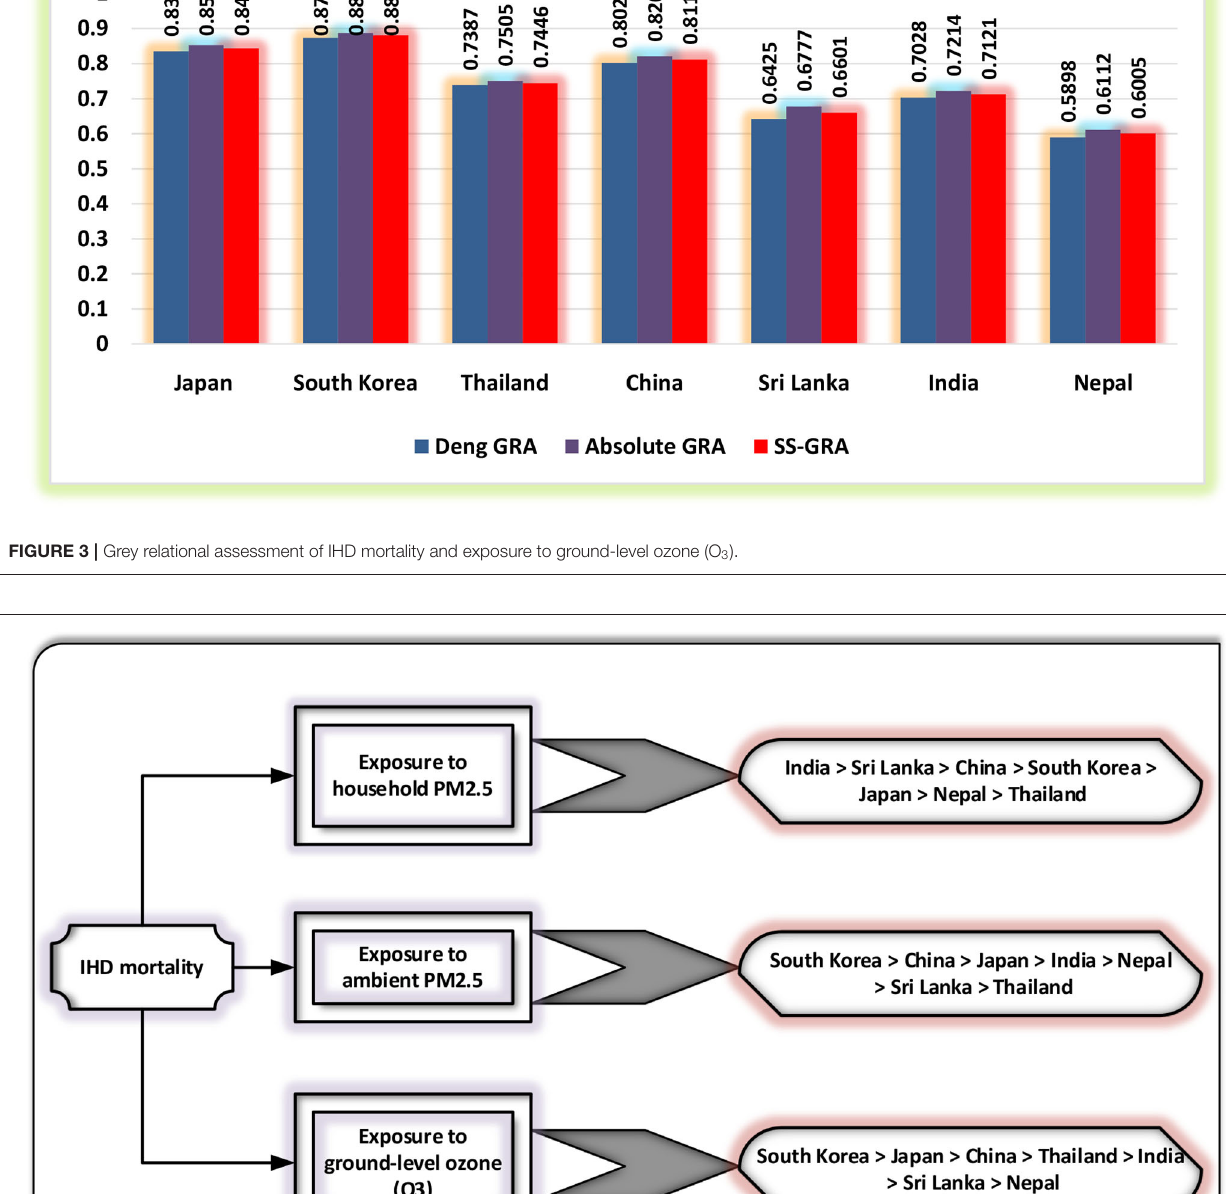
for the decision parameters. Figures 1 – 3 show a graphical representation of the GRA assessment between the studied variables and the air pollutants exposure. In addition, the ranking sequence based on GRA assessment can be seen in Figure 4